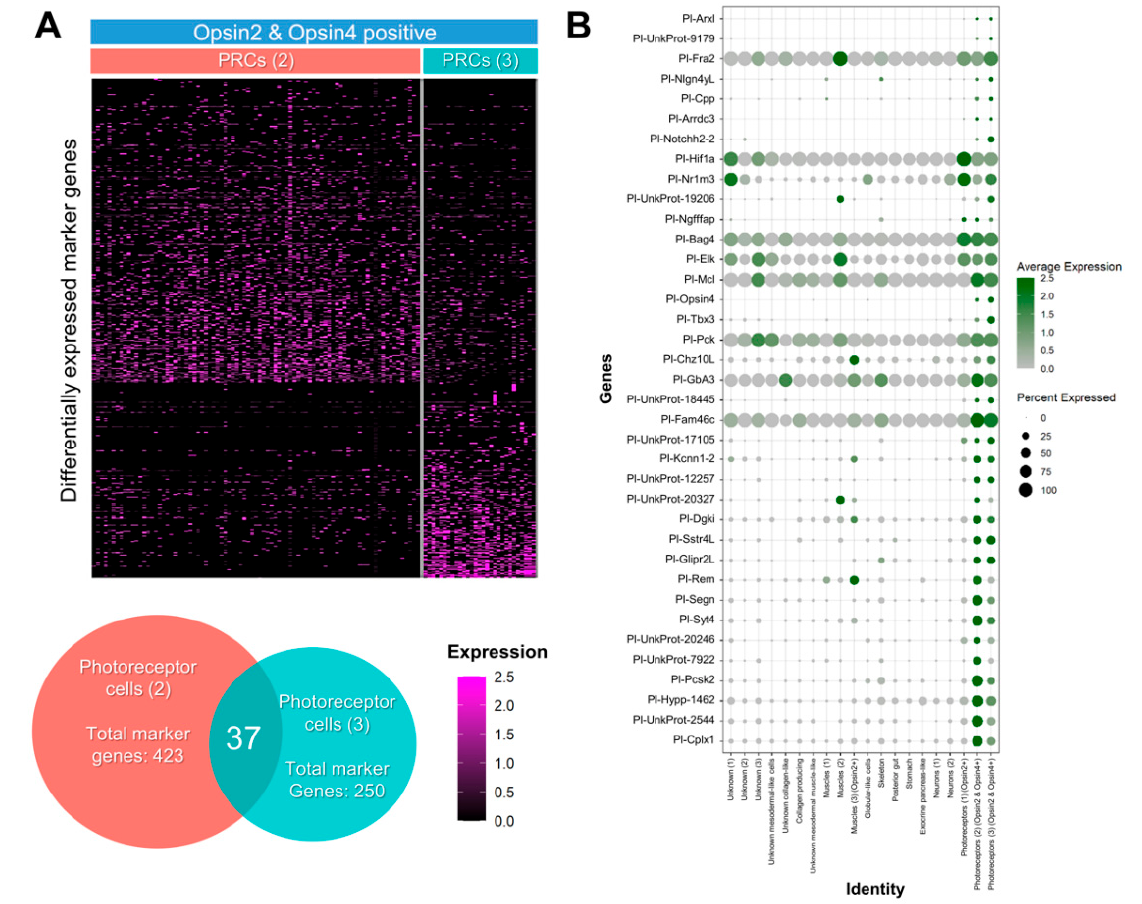
Figure 2. Photoreceptor cell type families and retinal molecular signature. ( A ) Heatmap and Venn diagram showing the differentially expressed marker genes between the two opsin2 / opsin4 double positive clusters (PCRs 2 and PCRs 3). ( B ) Dotplot showing the averaged scaled expression of common marker genes of the two opsin2 / opsin4 double positive clusters against the whole P. lividus mature rudiment atlas.